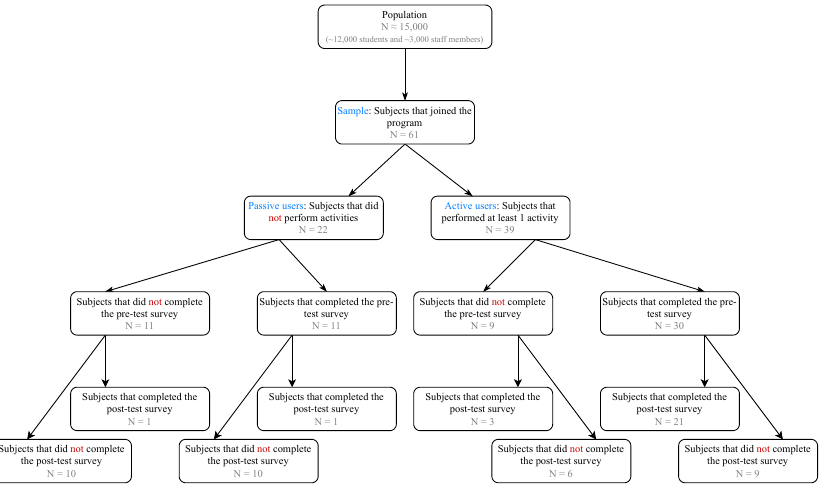
Figure 3. Cohort diagram that details the number of subjects engaged in different study